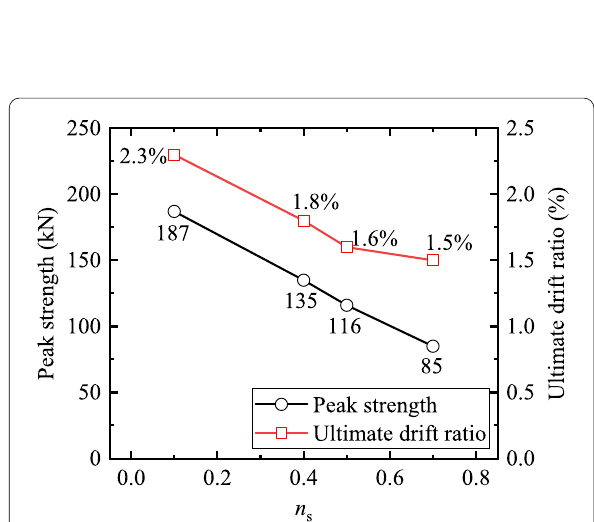
Fig. 13 Peak strength and ultimate drift ratio of specimens versus normalised reinforcement tensile stress.